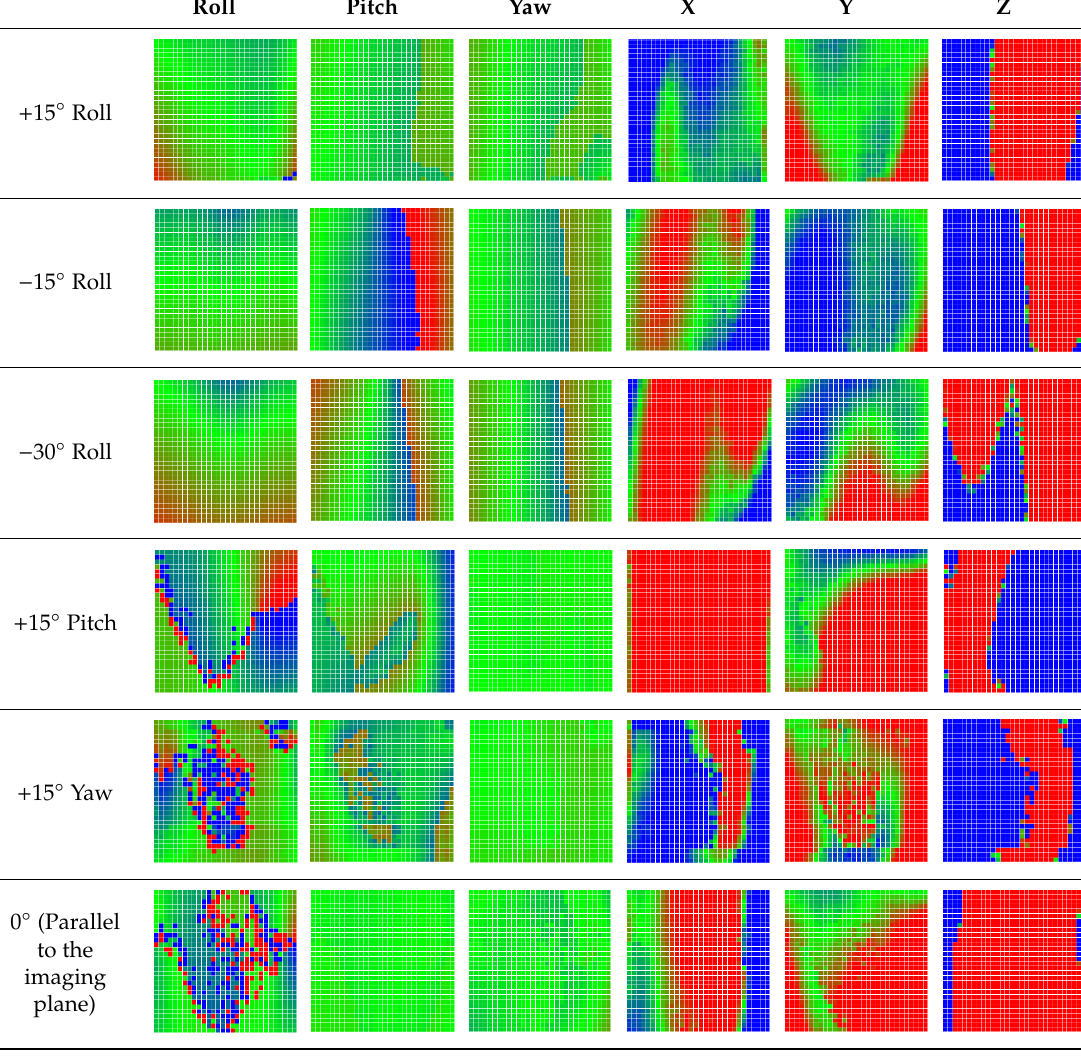
Table 3 leads us to the inference that the deviation map greatly varies with the rotation of the tags. To make the results clear, the deviations observed while detecting the pose of the tag are presented in the form of histograms in Table